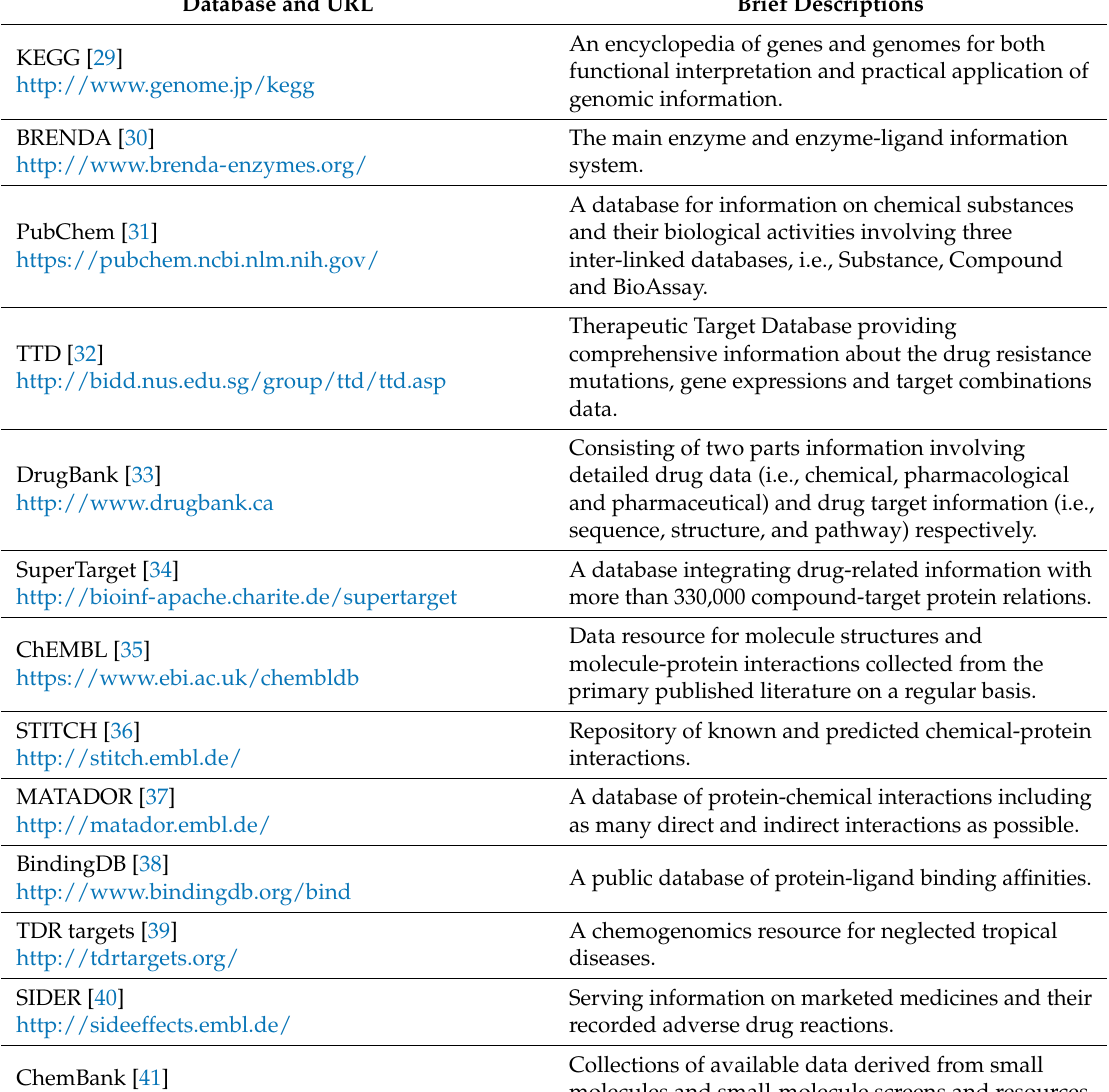
Table 1. Databases supporting drug discovery